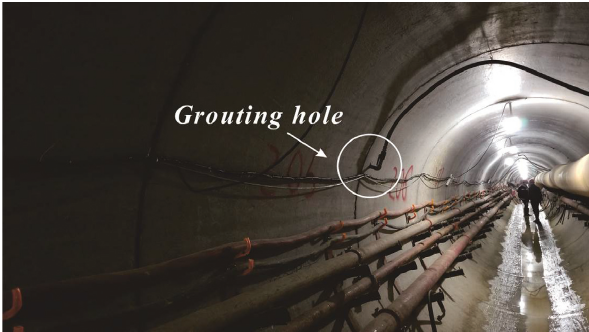
Figure 3: Spatial distribution of pipes with grouting holes.